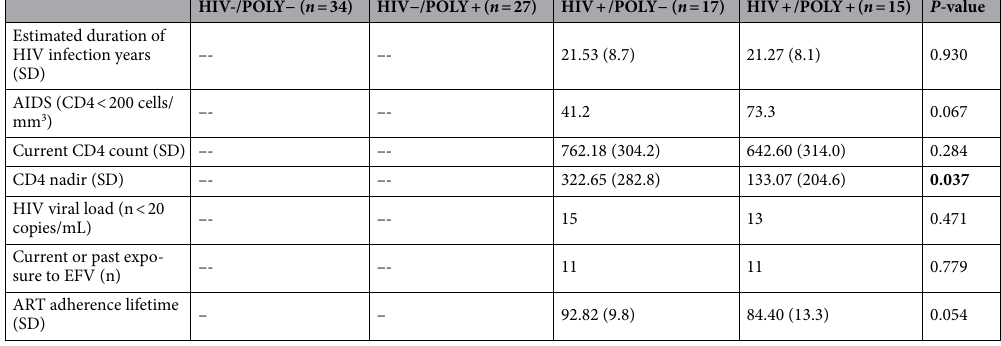
HIV clinical data. HIV-related clinical information was abstracted from participants’ medical records: dura- Table 2). We expanded search parameters for three participants who did not have CD4 values available within 6 months of the visit to a measurement within 5 years (HIV + /POLY-, n = 2; HIV + /POLY + , n = 1). Undetect- able viral loads were defined as < 20 copies/mL 35 . Three participants surpassed this threshold (HIV + /POLY- (36 copies/mL); HIV + /POLY + (23 and 97 copies/mL), but met criteria for viral suppression (defined as less than 200 copies/mL) 35–37 . Neuroimaging. Image acquisition. MRI scans were performed using a 3.0 Tesla Philips scanner (In- tera, CX, Achevia, and Elition models) and 32-channel head coil. Structural images were collected using a sagittal magnetization prepared gradient-echo (MPRAGE) sequence: repetition time /echo time = 6.9/3.3 ms;